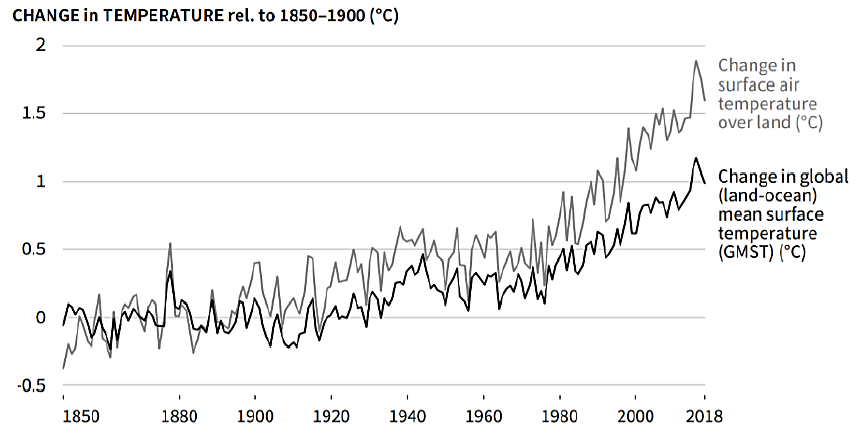
Figure 1. According to the Intergovernmental Panel on Climate Change (IPCC), since the pre-indus- trial period (1850 – 1900), the observed mean land surface air temperature has risen considerably more than the global mean surface (land and ocean) temperature.